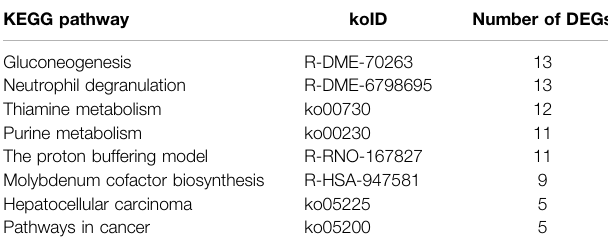
TABLE 2 | Top 8 KEGG pathways of the differentially expressed genes (DEGs).